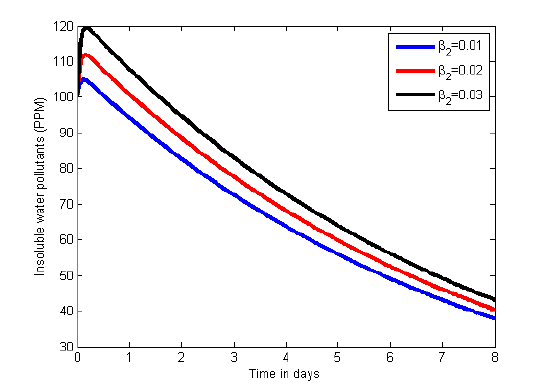
Fig. 3. Effect for the rate of water pollutants which are